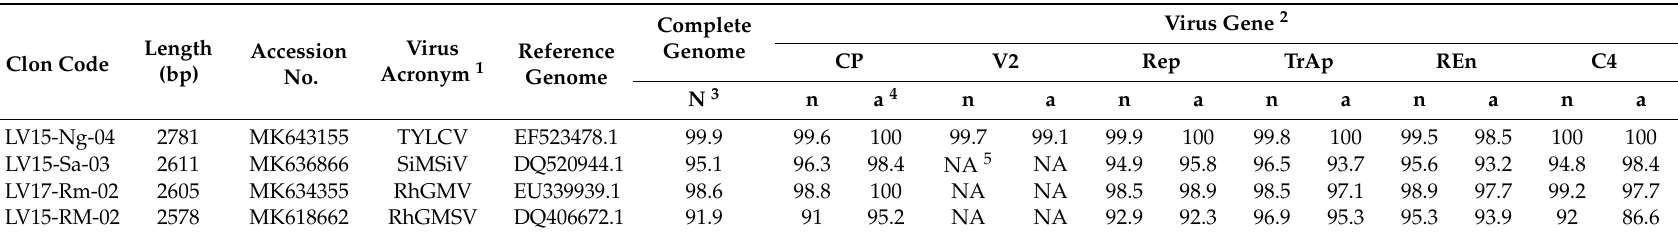
Table 4. Nucleotide and amino acid sequence identities (%) between DNA-A genome of Begomovirus isolates identified in the present study with best match sequences available in the